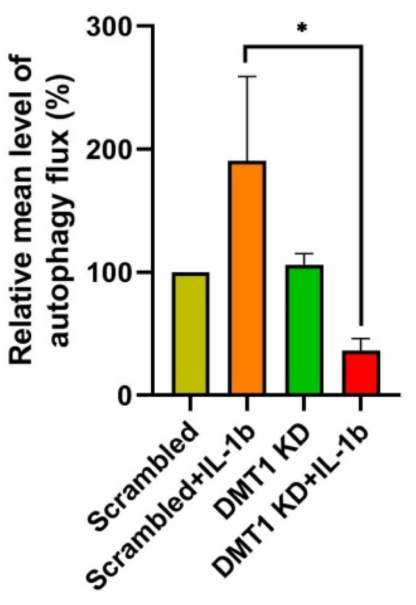
Figure 4. Quantification of autophagic activity using fluorescence spectrophotometric assay. The mean of relative fluorescence intensity was determined using CYTO-ID autophagy detection kit (Enzo life sciences), * p < 0.05, n = 3 biological